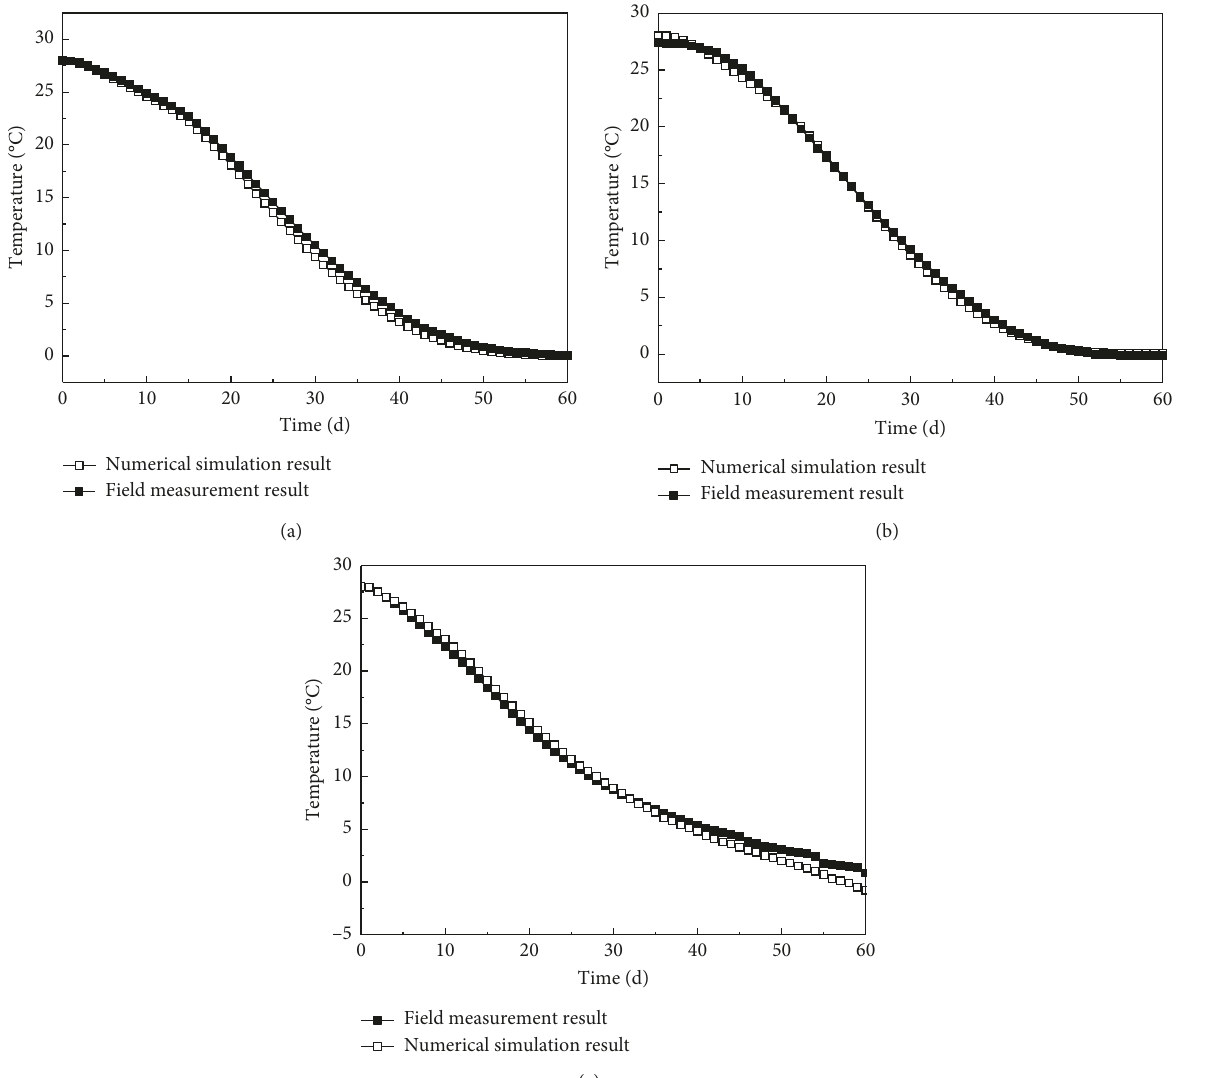
Figure 7: Comparison of simulated and measured results of (a) C1 temperature-measuring holes, (b) C2 temperature-measuring holes, and (c) C3 temperature-measuring